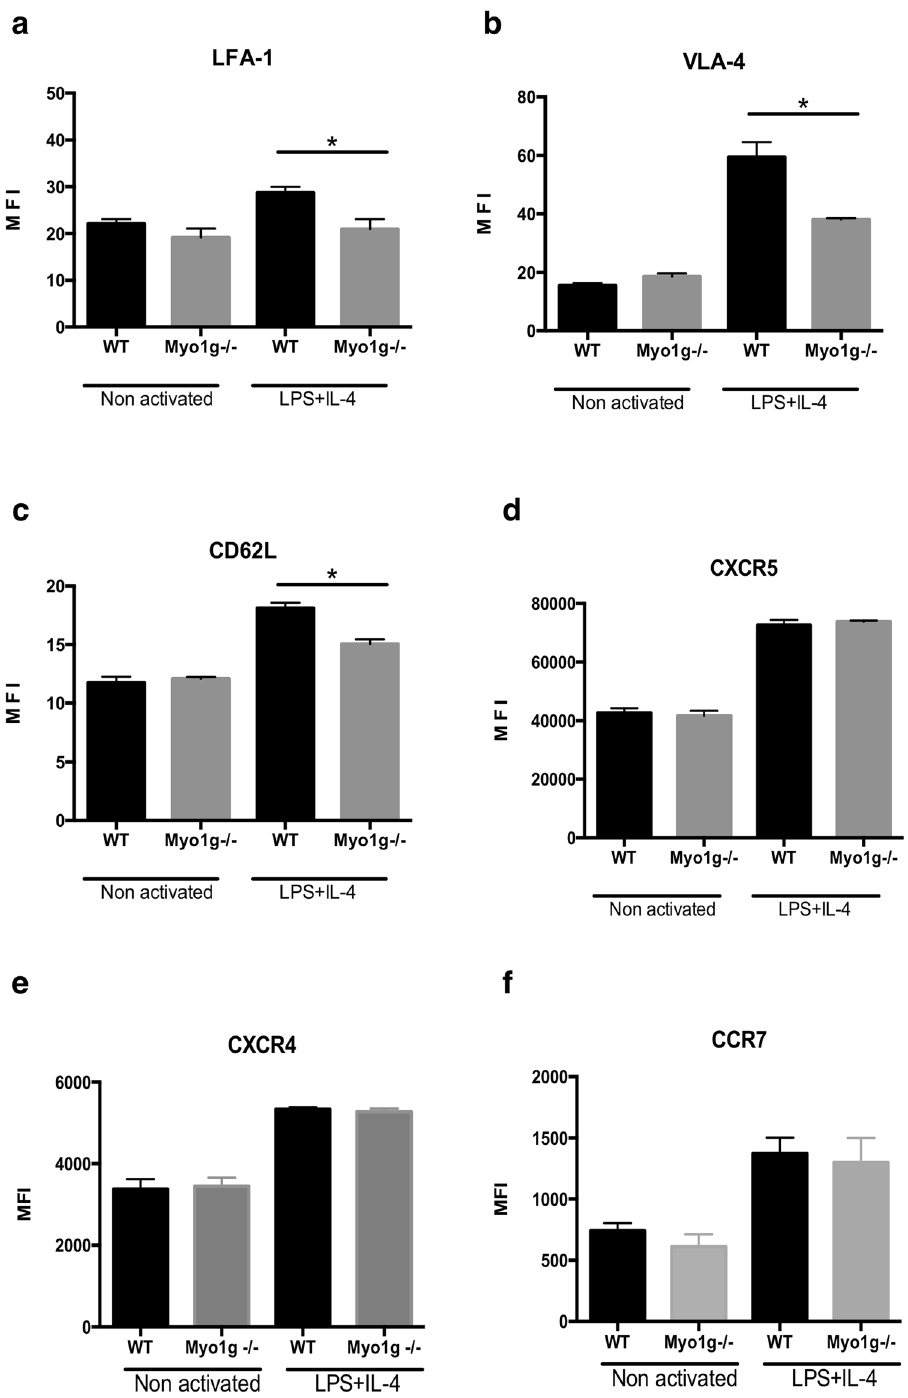
Figure 2. Myo1g is necessary for the surface expression of adhesion molecules in activated B lymphocytes. Graphical representation of mean fluorescence intensity values of ( a ) LFA-1, ( b ) VLA-4, ( c ) CD62L, ( d ) CXCR5, ( e ) CXCR4, ( f ) CCR7 in resting and LPS + IL-4 activated WT and Myo1g −/− B lymphocytes (n = 4). Data are presented as mean ± s.d. * P <